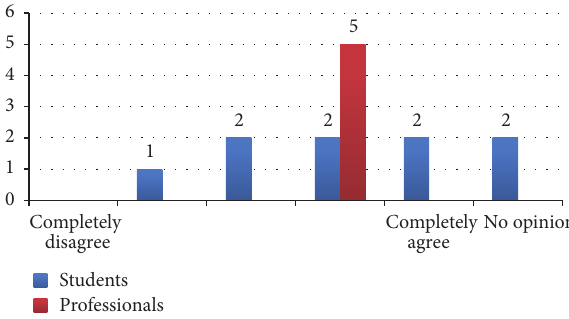
Figure 6: ECW/PUEA is a very good basis for group discussions.